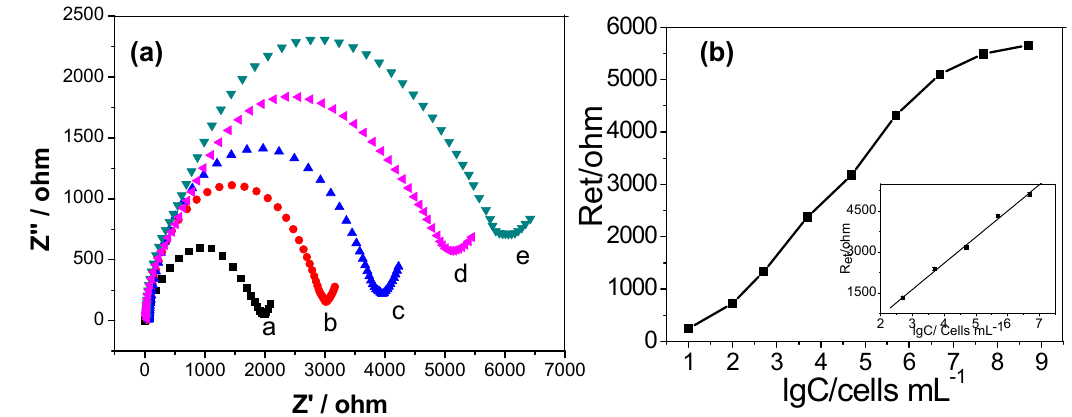
Figure 5. ( a ) Nyquist plots in 1.0 × 10 − 2 mol · L − 1 PBS (pH = 7.4) solution containing 0.1 mol · L − 1 KCl and 2.0 × 10 − 3 mol · L − 1 Fe(CN) 63 − /Fe(CN) 64 − recorded on the Cells/HG/GCE with the cell concentrations of 5.0 × 10 2 cells · mL − 1 , 5.0 × 10 3 cells · mL − 1 , 5.0 × 10 4 cells · mL − 1 , 5.0 × 10 5 cells · mL − 1 and 5.0 × 10 6